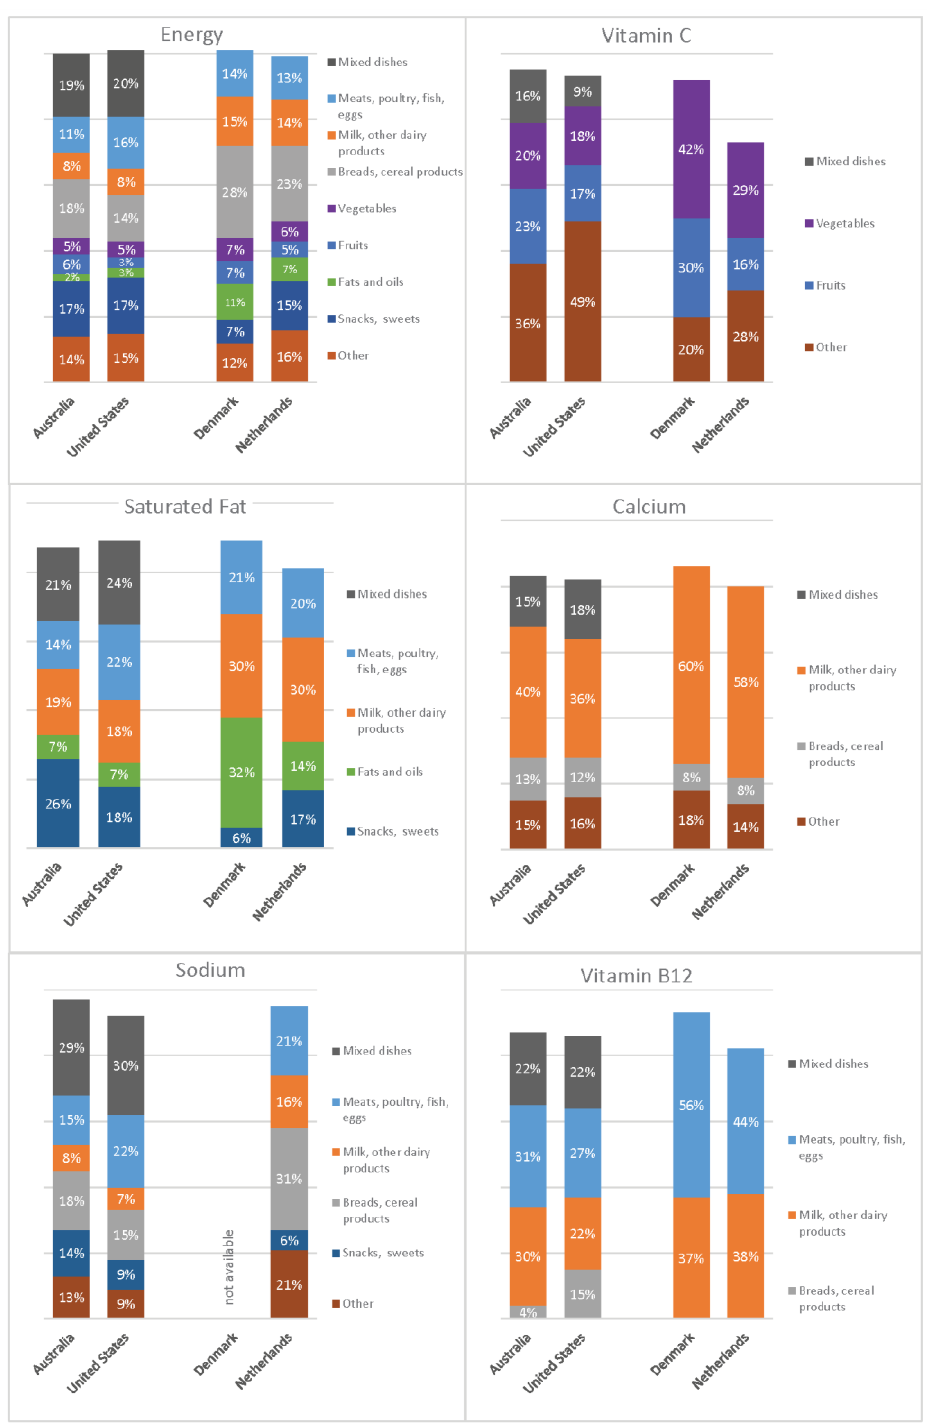
Figure 1. Percent contribution of food groups to daily energy and selected nutrient intakes in the total population in countries using the foods-as-consumed (Australia and the United States) and disaggregated (Denmark and the Netherlands) analyses methods (total population data for France not available). Countries using the disaggregated approach have eight food groups; countries using the foods-as-consumed approach have eight food groups plus a ninth mixed dishes group. For energy, percent nutrient contributions from all food groups are shown (bars may not total 100% due to rounding); for other nutrients, a food group is shown if it provided more than 10% of the daily intake in at least one